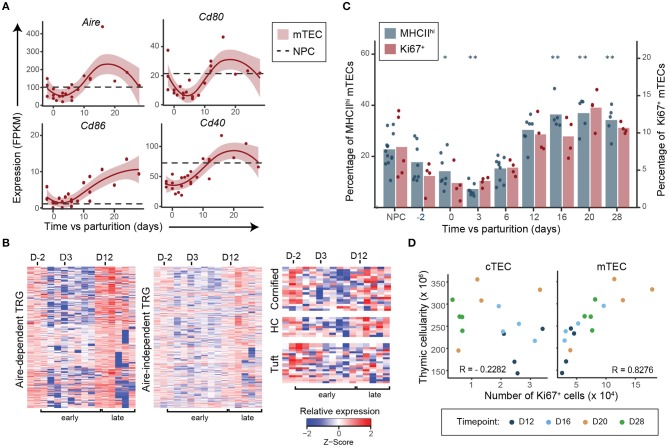
Expansion of SP thymocytes precedes differentiation of mTECs postpartum. (A) Expression of genes involved in SP thymocytes negative selection and associated with mTEC maturation. Each replicate is represented with a dot and a non-linear regression and the 95% confidence interval are displayed as lines and shaded area, respectively. Average expression in NPC is depicted with a dashed line. (B) Relative expression (Z-score) of Aire-dependent, Aire-independent tissue-restricted genes (TRG) (35), of genes associated with cornified cells, Hassall's corpuscles (HC) and tuft cells (36, 37) in mTECs during postpartum regeneration (NPC is shown in the first left column, then D-2 to D28 postpartum). Gene expression for each time point represents either average expression for triplicates, or raw expression value for single replicate. (C) Percentage of MHC-IIhi (n = 5–13) and Ki67+ (n = 4–5) mTECs. Means and individual replicate are depicted as bars and dots, respectively. Significance was assessed using one-way ANOVA followed by post-hoc Tukey test. p-values (*p < 0.05 and **p < 0.01) are shown against NPC only. (D) Pearson correlation between global thymic cellularity and the number of Ki67+ cTECs or mTECs from D12–D28.